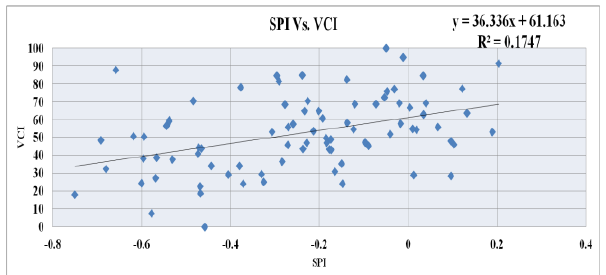
Figure 6. Correlation between Meteorological and Vegetation Drought